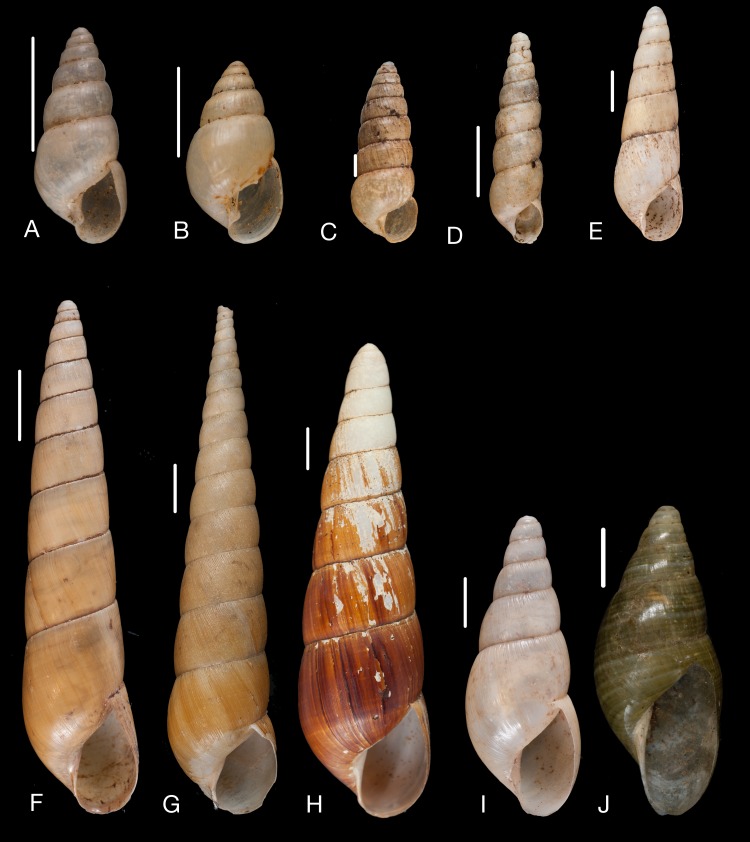
Material collected by the CCP.(A–H) Subulinidae. Leptinaria anomala (Pfeiffer, 1846), MNCN 15.05/20183, (A) ventral view; Leptinaria unilamellata (d’Orbigny, 1835), MNCN 15.05/20147, (B) ventral view; Stenogyra regularis (Pfeiffer, 1852), MNCN 15.05/39953, (C) ventral view; Subulina octona (Bruguière, 1792), MNCN 15.05/39954, (D) ventral view; Obeliscus haplostylus (Pfeiffer, 1846), MNCN 15.05/37048, (E) ventral view; Obeliscus cuneus riparius (Pfeiffer, 1854), MNCN 15.05/15511 (F) ventral view; Obeliscus obeliscus (Moricand, 1834), MNCN 15.05/15513, (G) ventral view; Neobeliscus calcareus (Born, 1778), MNCN 15.05/15512, (H) ventral view; Synapterpes auratus (Pfeiffer, 1846), MNCN 15.05/20330, (I) ventral view; Synapterpes visendus (Hidalgo, 1869), MNCN 15.05/3208, (J) ventral view. Scale line 1 mm (C), 1 cm (F–H), 5 mm (all others).